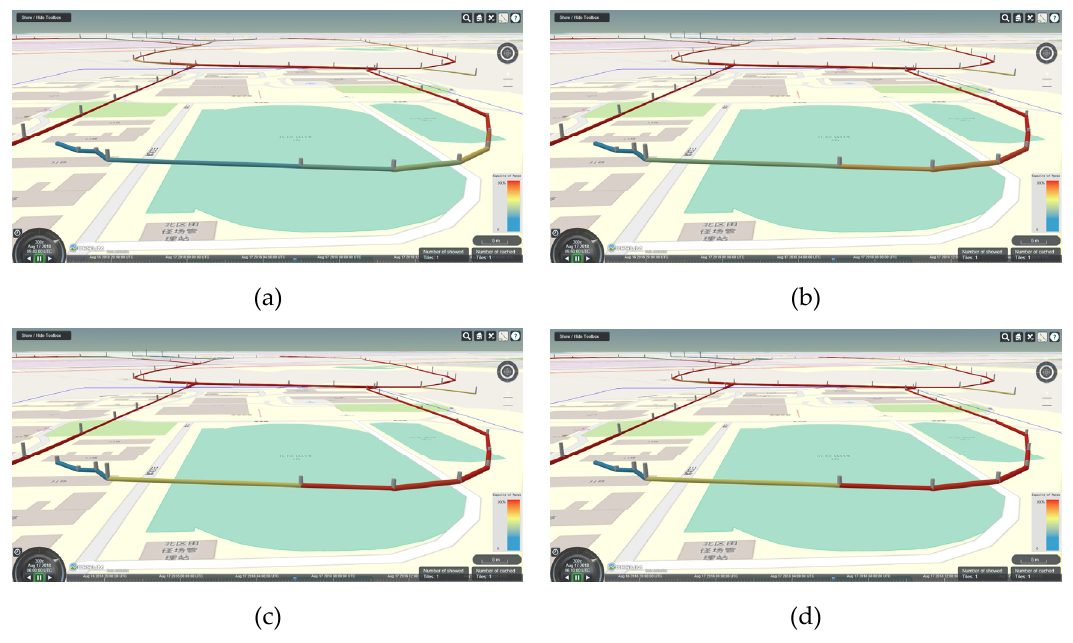
Figure 21 . The 3D dynamic process of flow of drainage pipelines in steps of 10 minutes. (a) to (d) are Figure 21. The 3D dynamic process of flow of drainage pipelines in steps of 10 min. ( a – d ) are the flow the flow load of drainage pipelines for every 10 minutes between 05:40 and 06:10 on August 17, 2018. load of drainage pipelines for every 10 min between 05:40 and 06:10 on 17 August